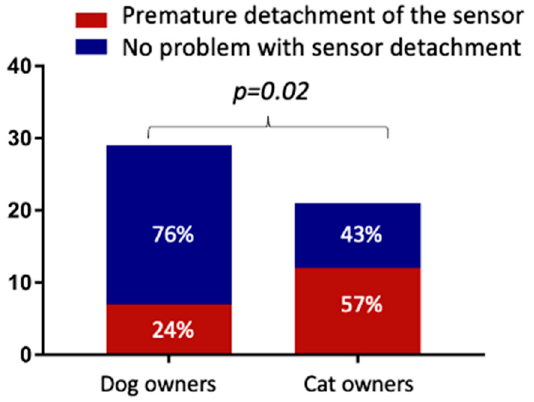
Figure 2. Comparison of dog and cat owners’ points of view regarding glycemic control of the flash glucose monitoring system (FGMS) when compared to blood glucose curves (BGCs).